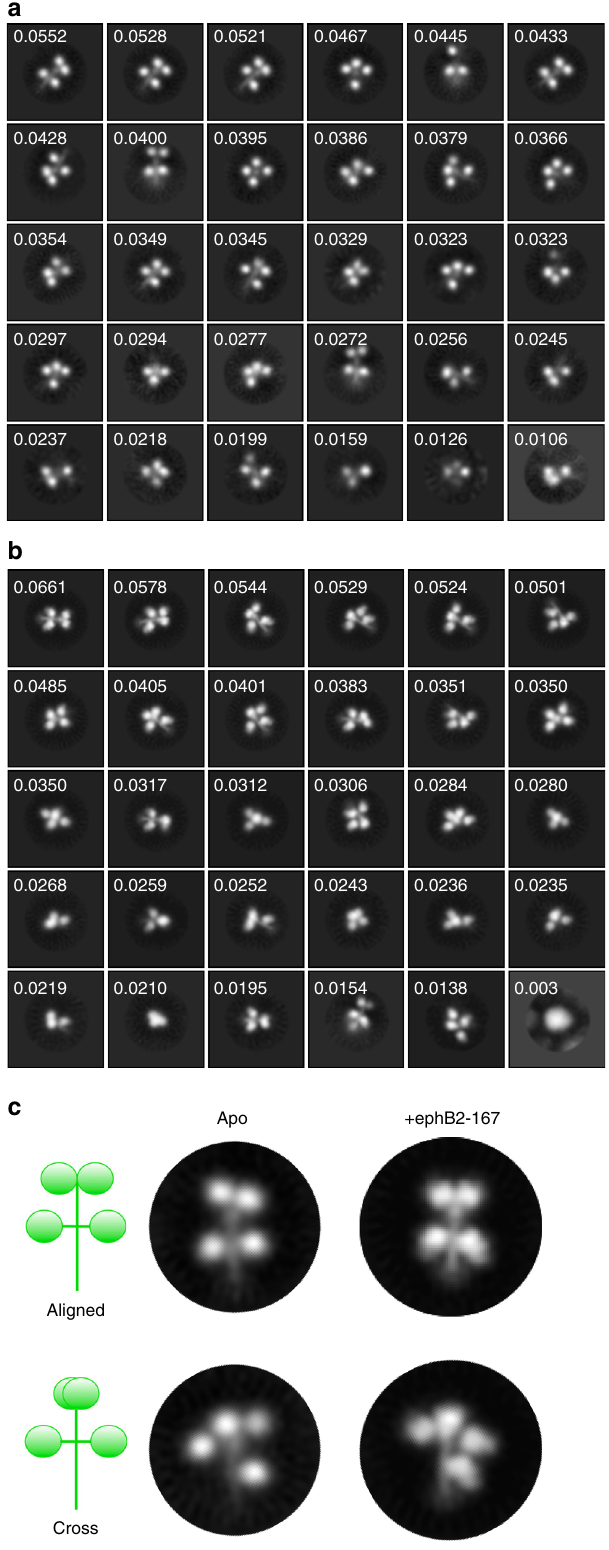
Fig. 4 Ectodomain of NiV G visualized by negative stain electron microscopy in the presence and absence of monomeric ephrinB2. a 2D class averages of apo-NiV G. Class distribution proportion is indicated for each class. b 2D class averages of NiV G bound to ephrinB2-167. Class distribution proportion is indicated for each class. c Representative 2D class averages of apo- and ephrinB2-167-bound NiV G, indicating fl exibility between the lower and apical pairs of NiV G globular